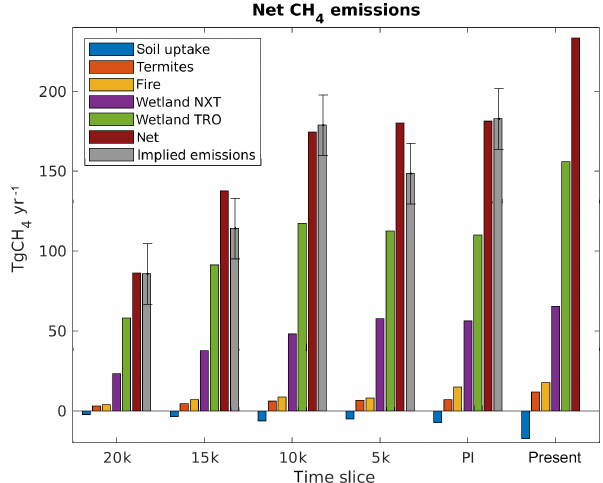
Figure 10. Components of the net CH 4 emissions for all time slices. Soil uptake of CH 4 is shown as a negative flux. Calculation of implied emissions and error bar as detailed in the